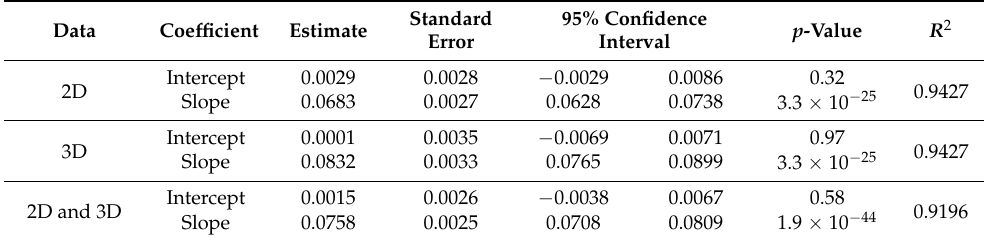
Table 4. Statistics of the linear regression models.